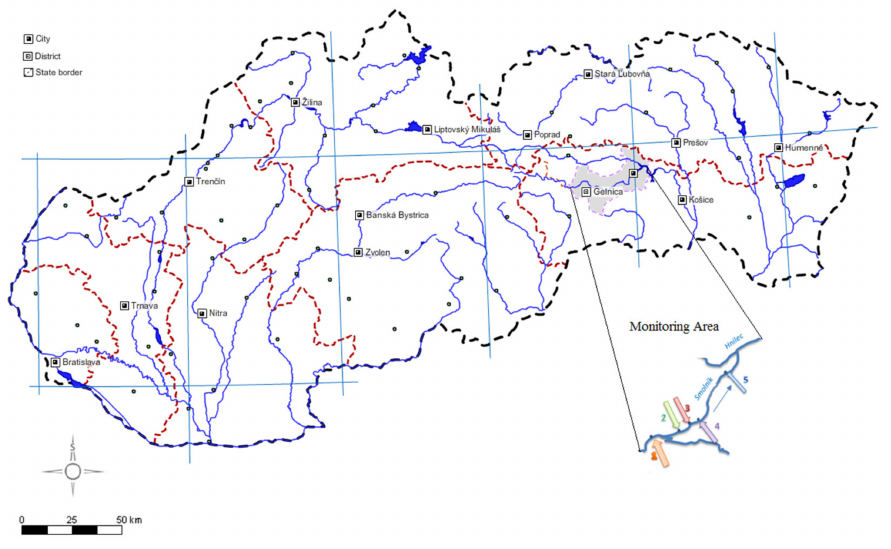
Figure 1. Location of the Smolnik River on the map of the Slovak Republic and sampling sites 1–5 in the study area. Table 1. GPS coordinates of sampling